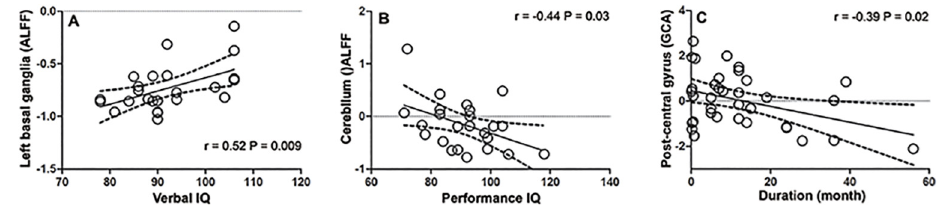
Fig 3. Correlation between fMRI measures and cognitive estimation or disease duration. (A) A positive correlation was identified for ALFF values in the putamen/caudate and VIQ scores. There were four children had same scores of verbal IQ(90), 4 points overlapping together, so there were only 22 points in the this figure. (B) The cerebellum and PIQ scores showed a negative correlation. (C) The causal effect from EZ to the left inferior frontal gyrus was negatively correlated with disease